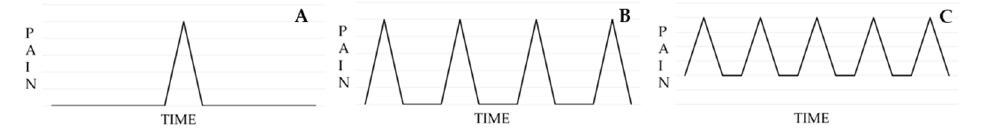
Figure 2. Attack forms in SUNHA headache: single stabs ( A ), groups of stabs ( B ), saw-tooth pattern ( C ). Abbreviations: SUNHA (Short-lasting Unilateral Neuralgiform Headache Attacks).